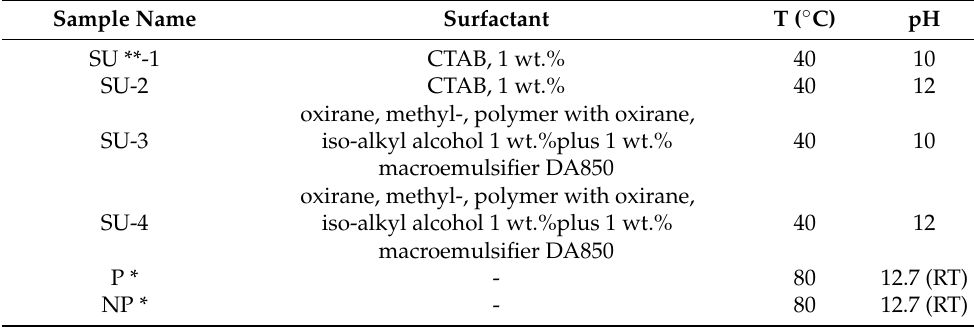
Table 4. Experiment setups of the scaled-up cleaning